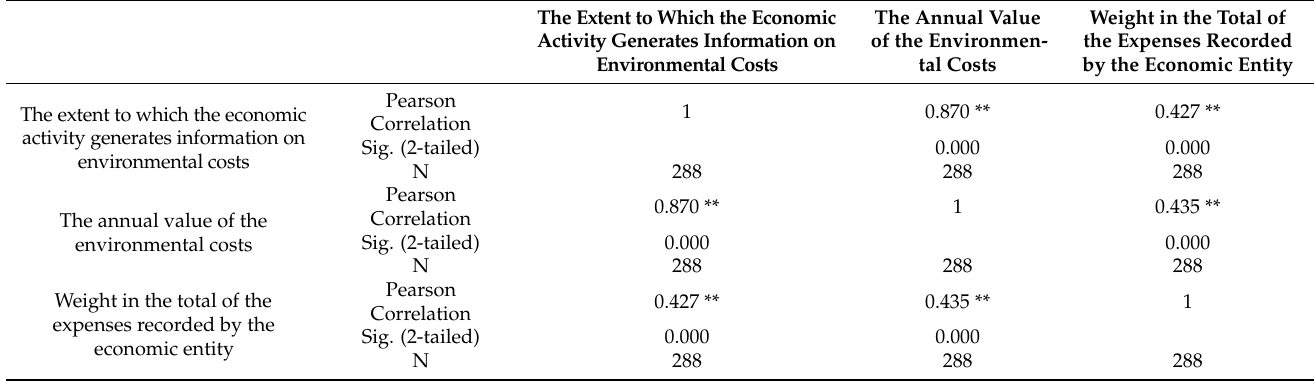
Table 12. Correlations of the analyzed